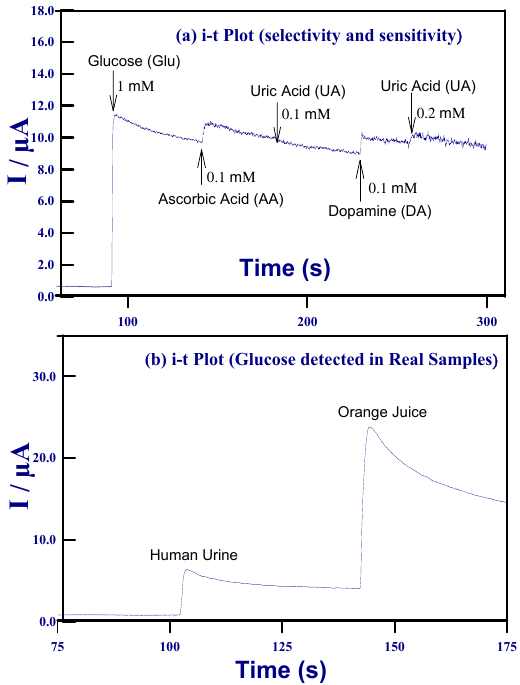
Figure 9. Amperometric i–t curve of a HCNiO/GC electrode in 0.05 M NaOH at E = 0.52 V for ( a ) an interference test in 1 mM glucose, including interferents of 0.1 mM ascorbic acid (AA), 0.1 mM uric acid (UA), 0.1 mM dopamine (DA), and 0.2 mM UA and ( b ) real samples of human urine and orange juice.